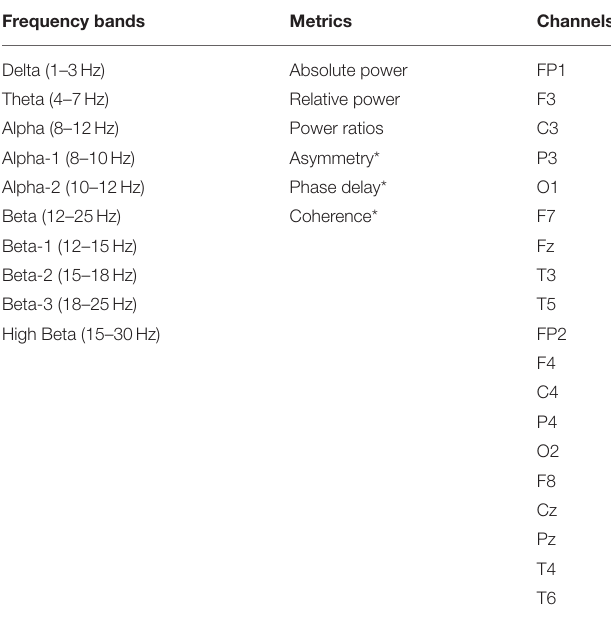
TABLE 1 | Live Z -score training EEG measurement